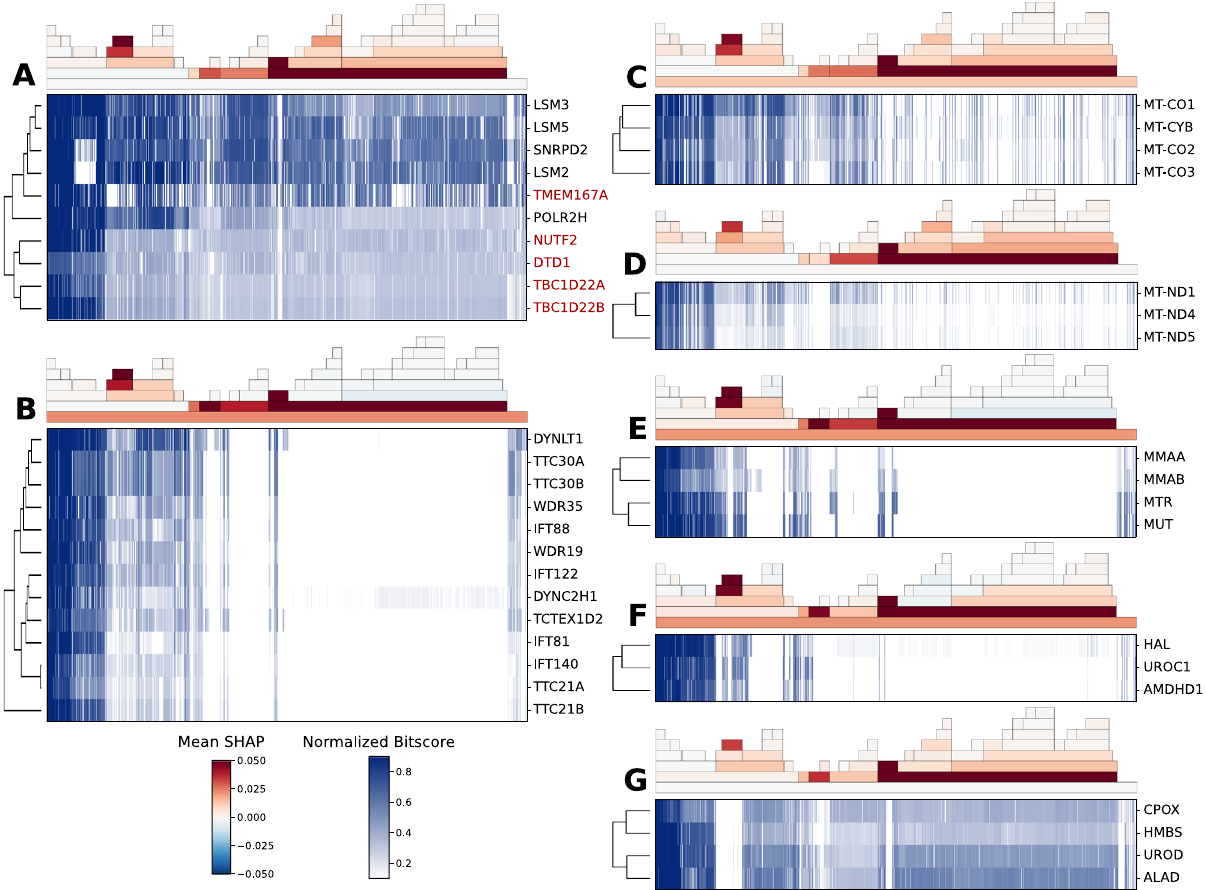
Fig. 3 Co-evolved gene clusters. Model predictions for functional interaction were clustered using hierarchical clustering and cut at speci fi c heights to produce clusters. For each of the clusters A – G, the top part is the clade importance for each clade calculated using the mean SHAP value, with species ordered from close (left) to distant (right) from human. The bottom part is the phylogenetic pro fi le as self-hit normalized bitscores. Sub fi gures correspond to the co-evolved genes in the pathways mRNA splicing ( A ), cilia ( B ), mitochondrial respiratory complexes III and IV ( C ), NADH dehydrogenase ( D ), B12 metabolism ( E ), histidine metabolism ( F ) and heme biogenesis ( G ). Red entries in A denote genes not known to take part in mRNA